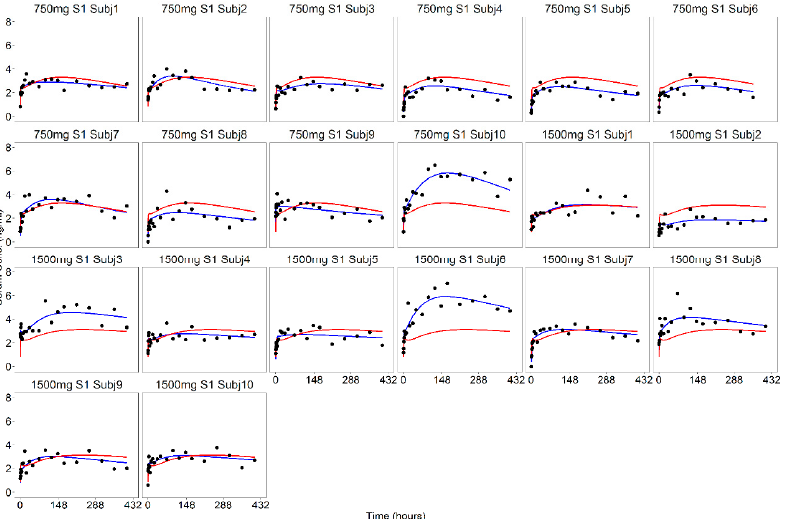
Figure 7. Model predictions of the individual (blue lines) and population (red lines) serum concentration profiles at 750 and 1500 mg dose levels together with observations (black dots).